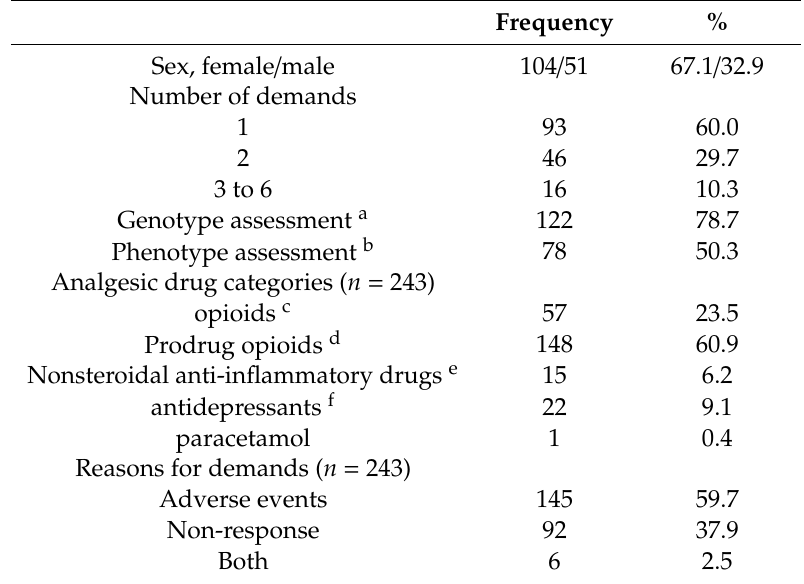
Table 2. Characteristics of patients ( n = 155) and demands ( n =